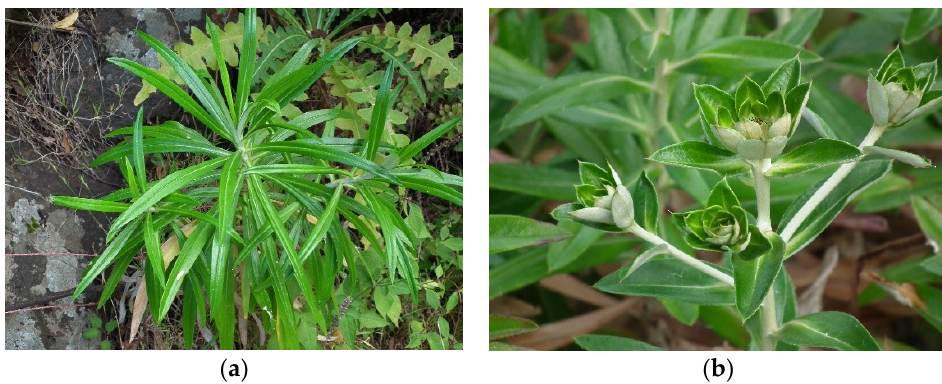
Figure 1. On the island of La Palma (Canary Islands) just one species of the genus Carlina L. with narrow leaves is listed in most floras. This species ( C. falcata Svent.) ( a ) is relatively abundant and widespread on the island. However, in remote parts of northern cliffs a subspecies of